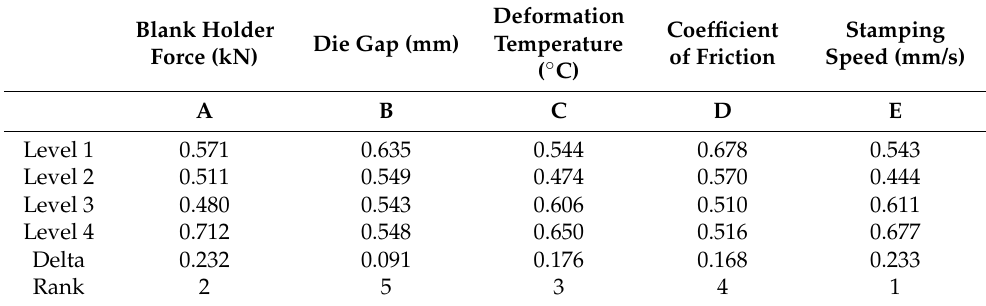
Table 7. Different level GRG Mean table (ANOR).